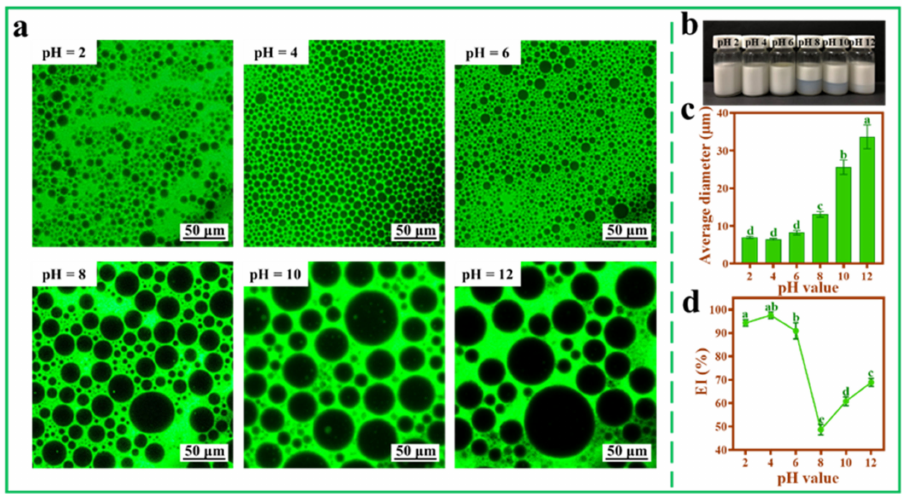
Figure 6. Inverted fluorescence microscopy images ( a ), photograph ( b ), average diameter ( c ), and EI% ( d ) of Pickering emulsions at different pH (2, 4, 6, 8, 10, and 12; ω (NaCl) = 0, ω (TOCNFs) = 0.9 wt%, 450 W). Different letters of a, b, c and d show significant